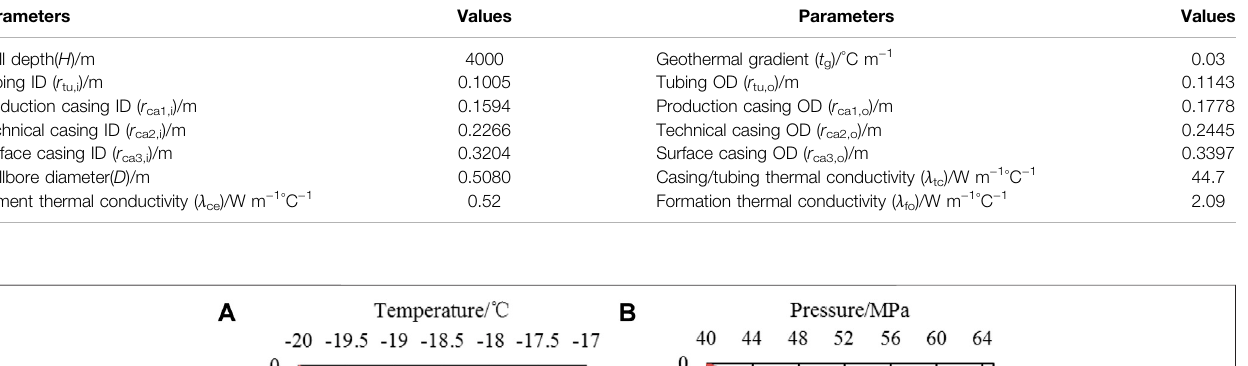
TABLE1 | The calculation parameters. Parameters